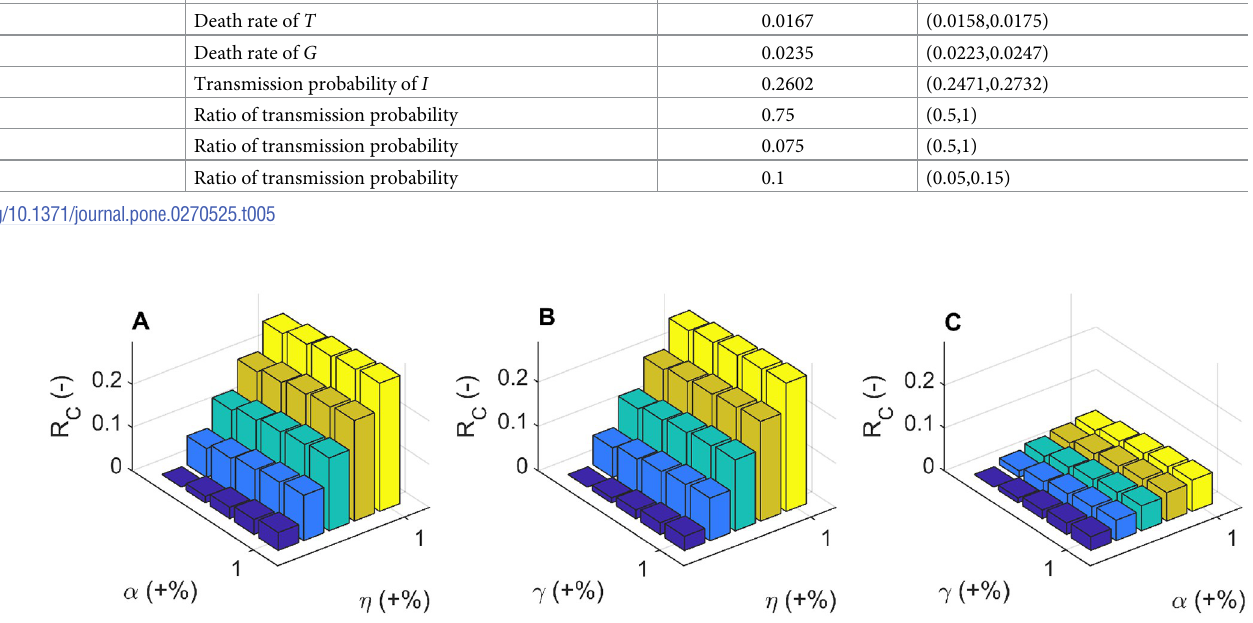
Fig 7. The reduction of the reproduction number ( R C ( − )). The reduction of the reproduction number ( R C ( − )) under different combinations of the improvement of diagnosis rate ( α (+ %), the improvement of protection rate ( η (+ %)), and the improvement of ART enrolment rate ( γ (+ %)). (A) R under the combination of α (+ %) and γ (+ %). (B) R C ( − ) under the combination of α (+ %) and η (+ %). (C) R C ( − ) under the combination of γ (+ %) and α (+ %). ART: Antiretroviral treatment.